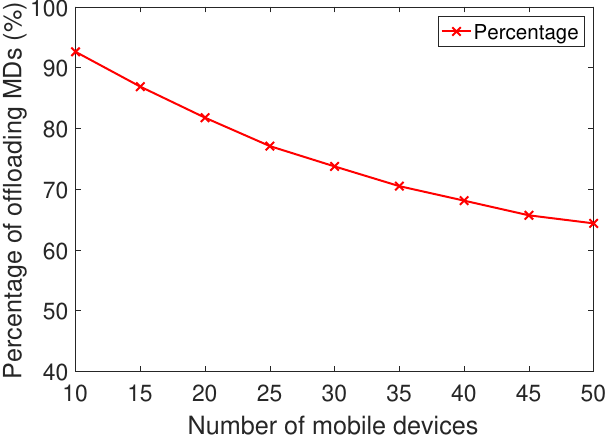
Figure 3. Percentage of offloading mobile devices (MDs) according to the number of